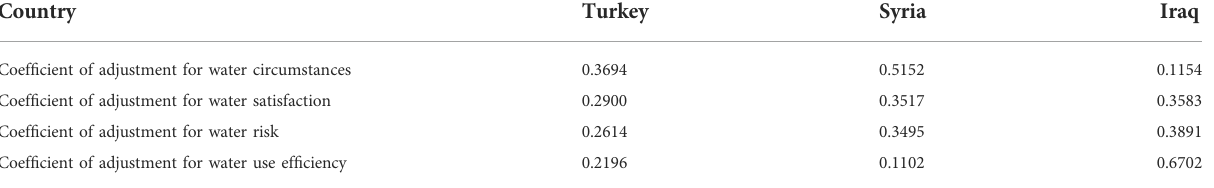
TABLE 9 Second stage of water allocation result in the Tigris- Euphrates river. Country Allocation